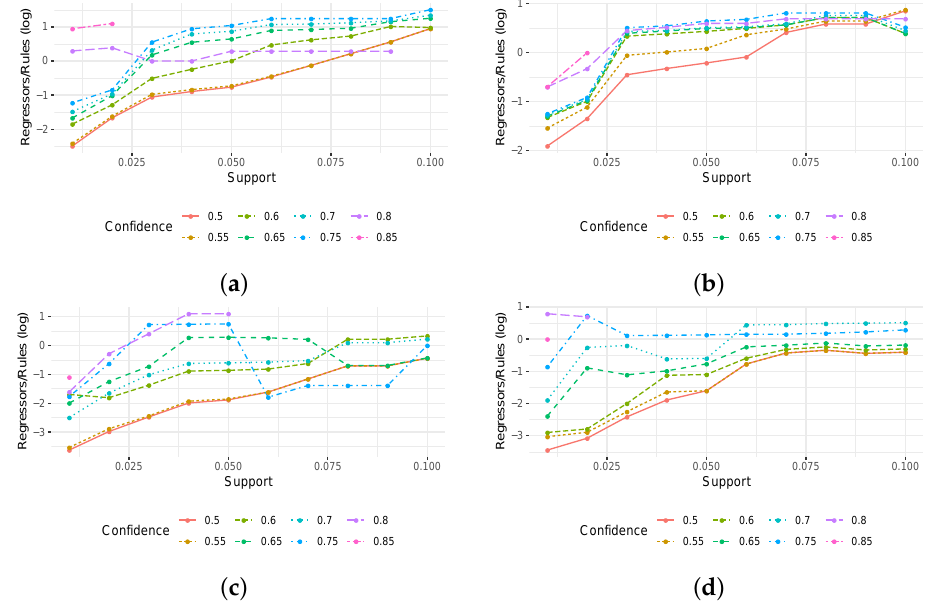
Figure 5. Fraction of obtained models per rules for all datasets: ( a ) no noise, no overlap; ( b ) no noise, overlap; ( c ) noise, no overlap; ( d ) noise,